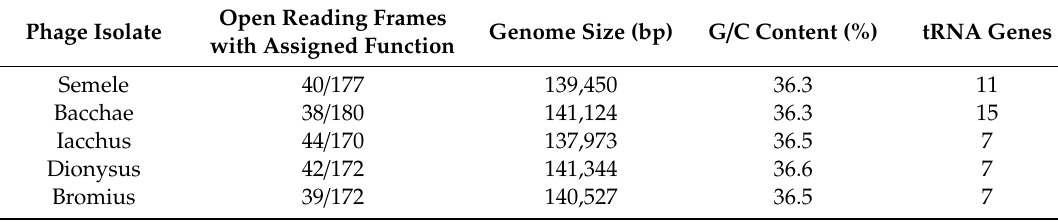
Table 2. Basic genomic characteristics of the five Lactobacillus phage isolates.